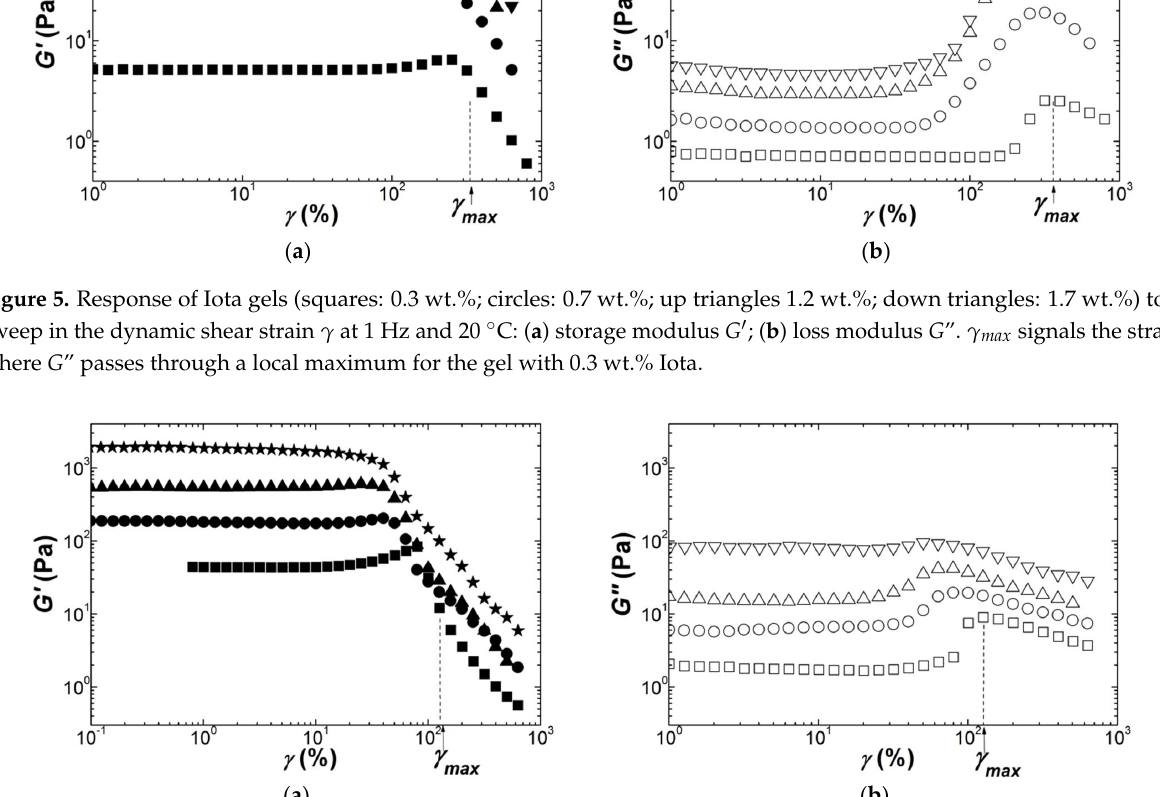
( b ) Figure 7. Strain dependence of the shear storage modulus G′ scaled by the linear shear modulus G 0 of the corresponding gels: ( a ) Iota gels with 0.3 wt.% (squares), 0.5 wt.% (circles), 0.7 wt.% (up triangles), 0.8 wt.% (down triangles), 1.1 wt.% (diamonds), 1.25 wt.% (stars) and 2 wt.% (line); ( b ) Kappa2 gels with 0.5 wt.% (squares), 0.75 wt.% (circles) and 1.1 wt.% (triangles). Insets present the concentration dependence of G 0 and lines are power law fits to the data. Therefore, the comparison of the theories designed for networks of filaments with the elastic data presented in Figure 7 can now be performed.